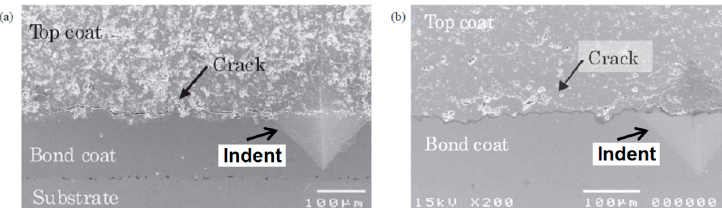
Figure 10. Typical interfacial cracks initiated by the indentation test: ( a ) for 0 thermal cycles (As-sprayed); ( b ) after 500 cycles [39]. Reproduced with permission from S. Kuga et al., Procedia Engineering; published by Elsevier,